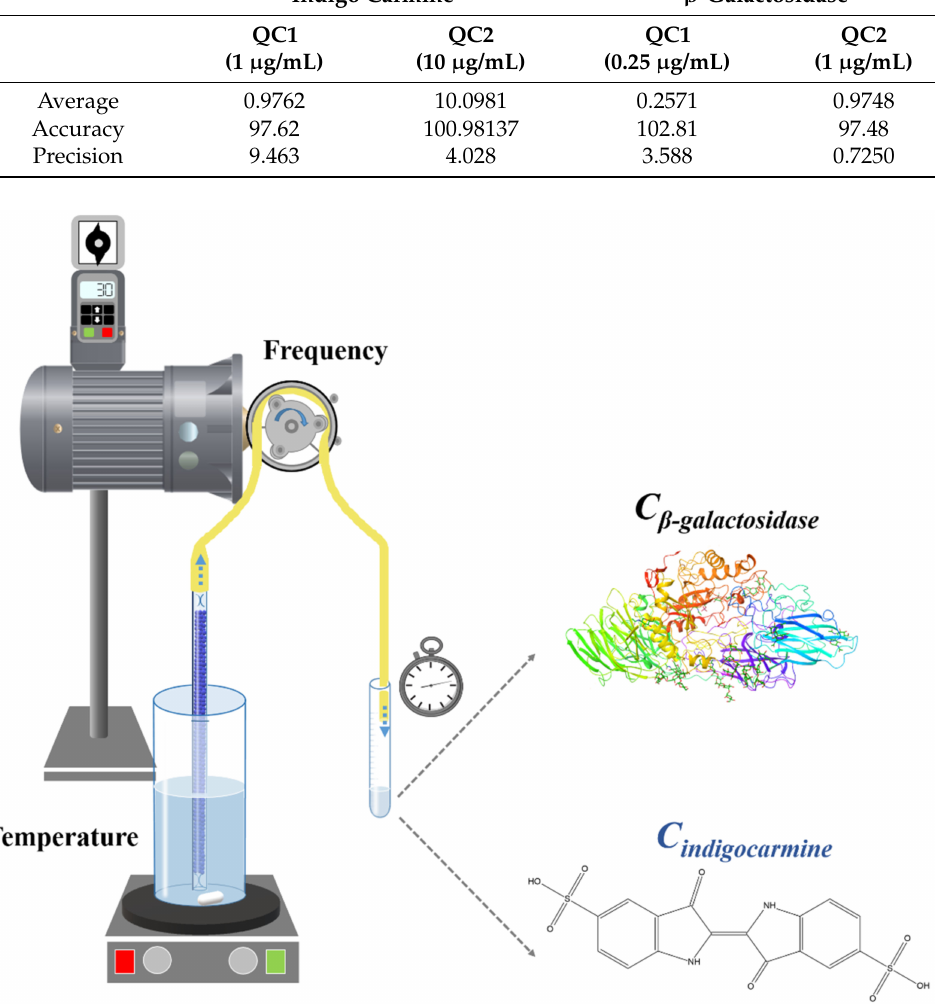
Figure 1. The apparatus for simulating the sipping of liquid through the straw. The measurement lasted for 3 min, during which 7 samples were taken. The first 4 samples were taken in the first minute with 15 s intervals, then at 90 and 120 s, and finally the last at 3 min. All the measurements were performed parallel on 3 different